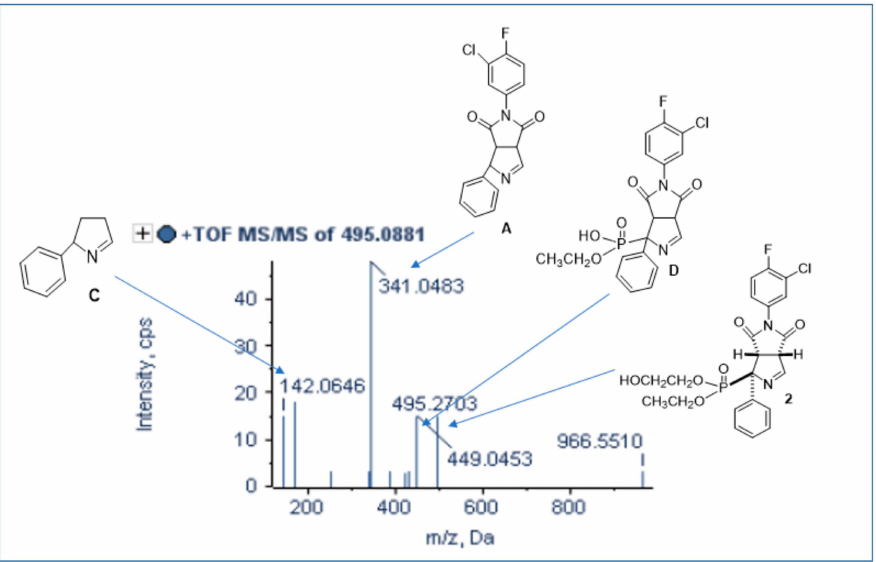
Figure 11. MS/MS spectra at 480 min of the characteristic fragmentation pattern of B06 metabolite 2 in in vivo